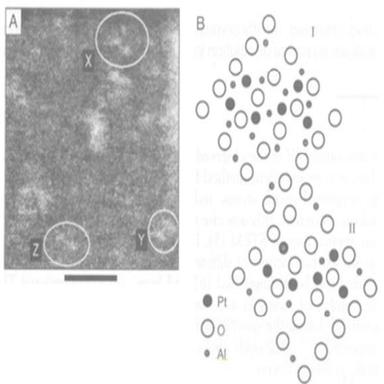
STEM image of Pt clusters on γ-Al2O3 (A). Schematic of the alumina surface with Pt trimer formation showing isosceles triangle shape (B). Reprinted with permission from Copyright 1996 The American Association for the Advancement of Science.